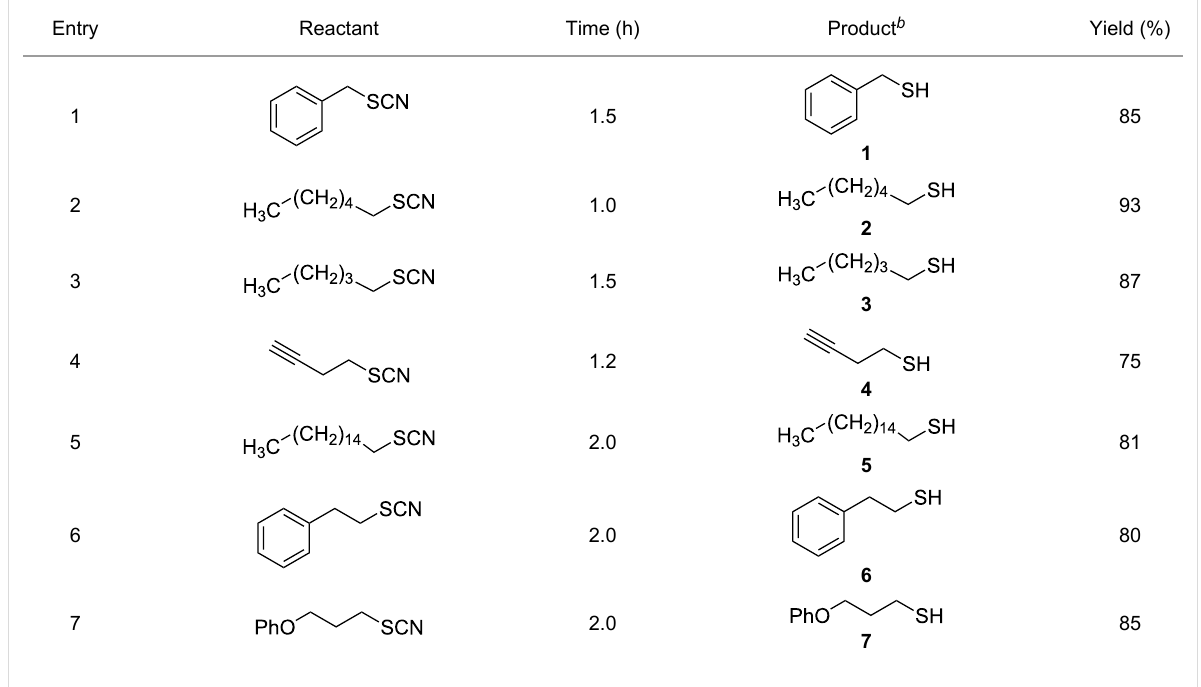
Table 2: Conversion of different thiocyanates to thiols with P 2 S 5 in refluxing toluene a . Entry